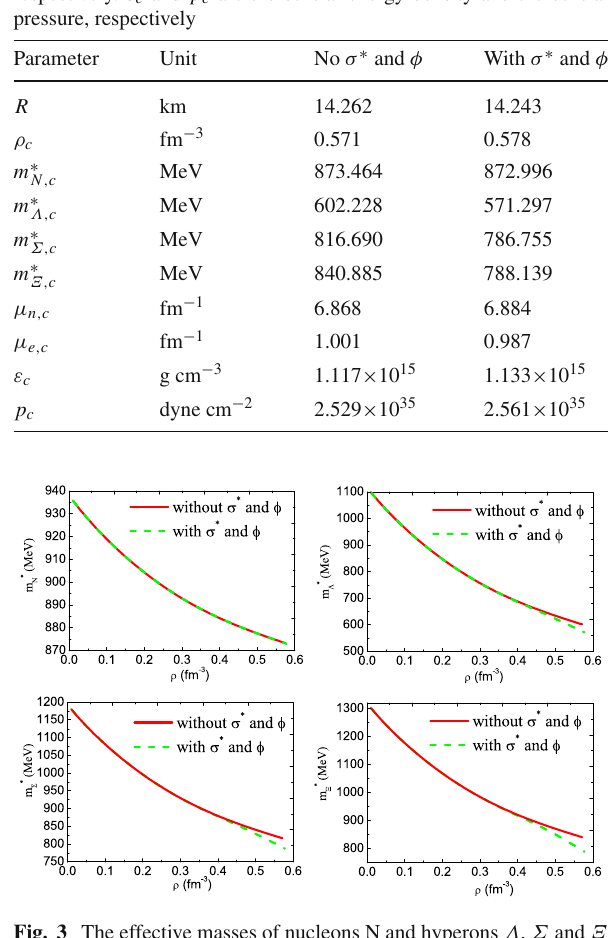
Fig. 3 The effective masses of nucleons N and hyperons Λ , Σ and Ξ as a function of baryon density. The thick solid red curves represent the case where the hyperon interaction is not considered, while the green virtual curves represent the case where the hyperon interaction is considered